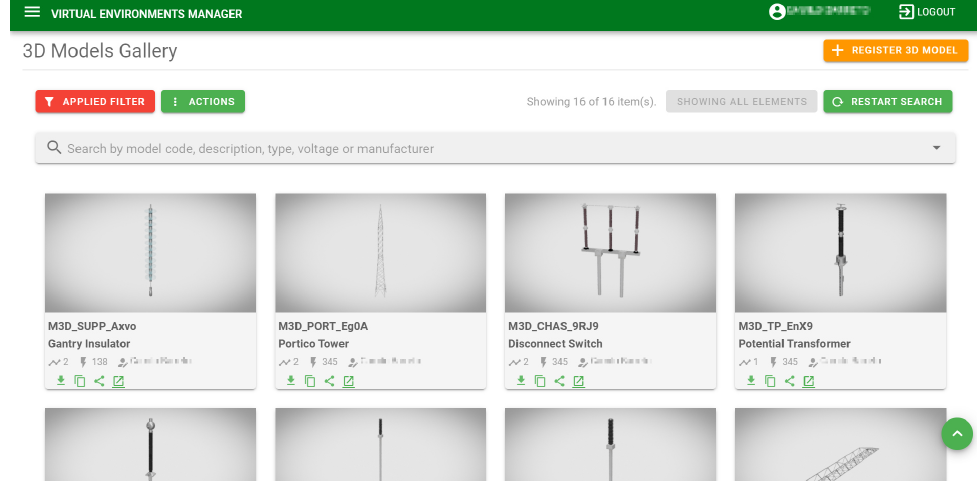
Figure 17. Virtual Environments Manager implemented on AWS, with the gallery of 3D models. The process of preparing the virtual EPS were done in the design stages of the VEs. Users were granted access to the VEM and CADE, along with the registered virtual assets.